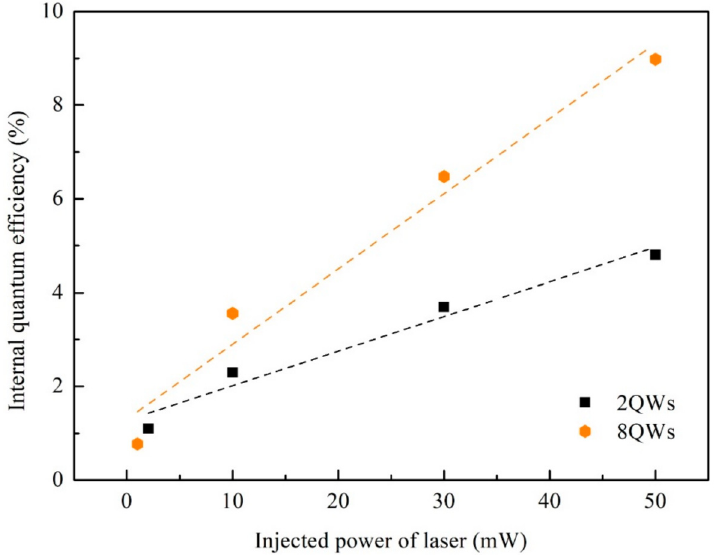
Figure 1. The internal quantum efficiency of sample 2QW and 8QW under different excitation power; the dotted lines are guides to